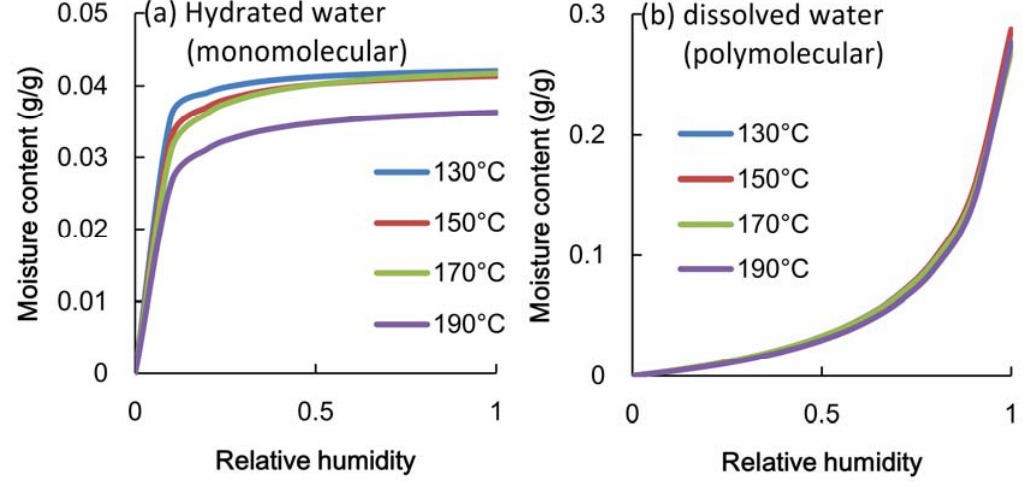
Figure 7. ( a ) Moisture content of hydrated water (monomolecular) in heated